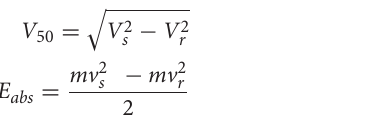
II (436 m/s), level III (448 m/s), level IIIA (847 m/s), and